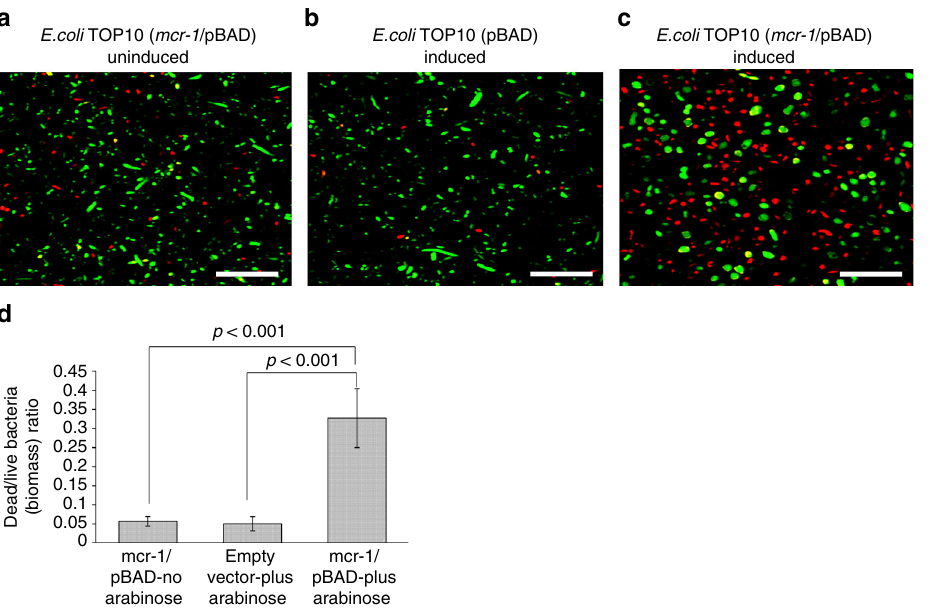
Fig. 4 The toxic effects of mcr-1 overexpression on cell viability. a – c Confocal laser scanning microscopy images of cells treated with/without L -arabinose and stained with LIVE/DEAD ® ( n = 3). Live and dead cells presented green and red colour, respectively. Scale bar is 15 µ m. d Ratio of dead to live bacteria (biomass) obtained from CLSM z -stack images through COMSTAT analysis of E. coli bio fi lms grown for 16 h in LB broth, followed by ± L -arabinose (0.2% w/v; 8 h) treatment, where the bio fi lms were stained with LIVE/DEAD ® ( n = 4). The COMSTAT data was assessed using one-way analysis of variance (ANOVA) followed by Tukey – Kramer multiple comparisons post hoc test. Statistical signi fi cance was set at p <